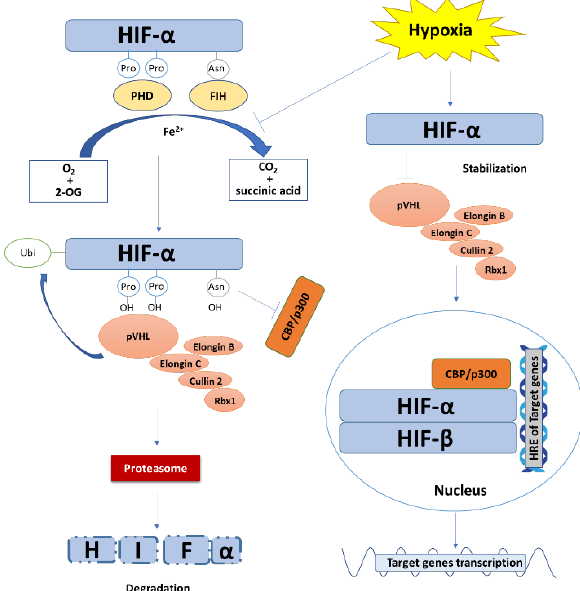
Figure 1. The degradation, stabilization, and transcriptional function of HIF. Under normoxic condition, with Fe 2+ as a cofactor and oxygen and 2-oxoglutaric acid (2-OG) as substrates, PHD and FIH hydroxylate HIF- α at the site of two proline residues and an asparagine residue in ODDD, respectively, accompanied by the generation of carbon dioxide and succinic acid as by-products. The prolyl hydroxylated HIF- α is preferentially recognized and ubiquitinated by VCB-Cul2 E3 ligase complex and is then targeted to proteasome for degradation. Meanwhile, hydroxylation of the asparagine residue of HIF- α prevents its recruitment and binding to coactivator p300 and CBP. Under hypoxic stress, the hydroxylation reaction of PHD and FIH is inhibited. The VCB-Cul2 E3 ligase complexes are not able to recognize and ubiquitinate HIF- α , leading to the stabilization and accumulation of HIF- α . HIF- α then translocates into the nucleus, heterodimerizes with HIF- β , and recruits coactivator p300 and CBP to specifically bind to the hypoxia response elements (HRE) of target genes, resulting in gene